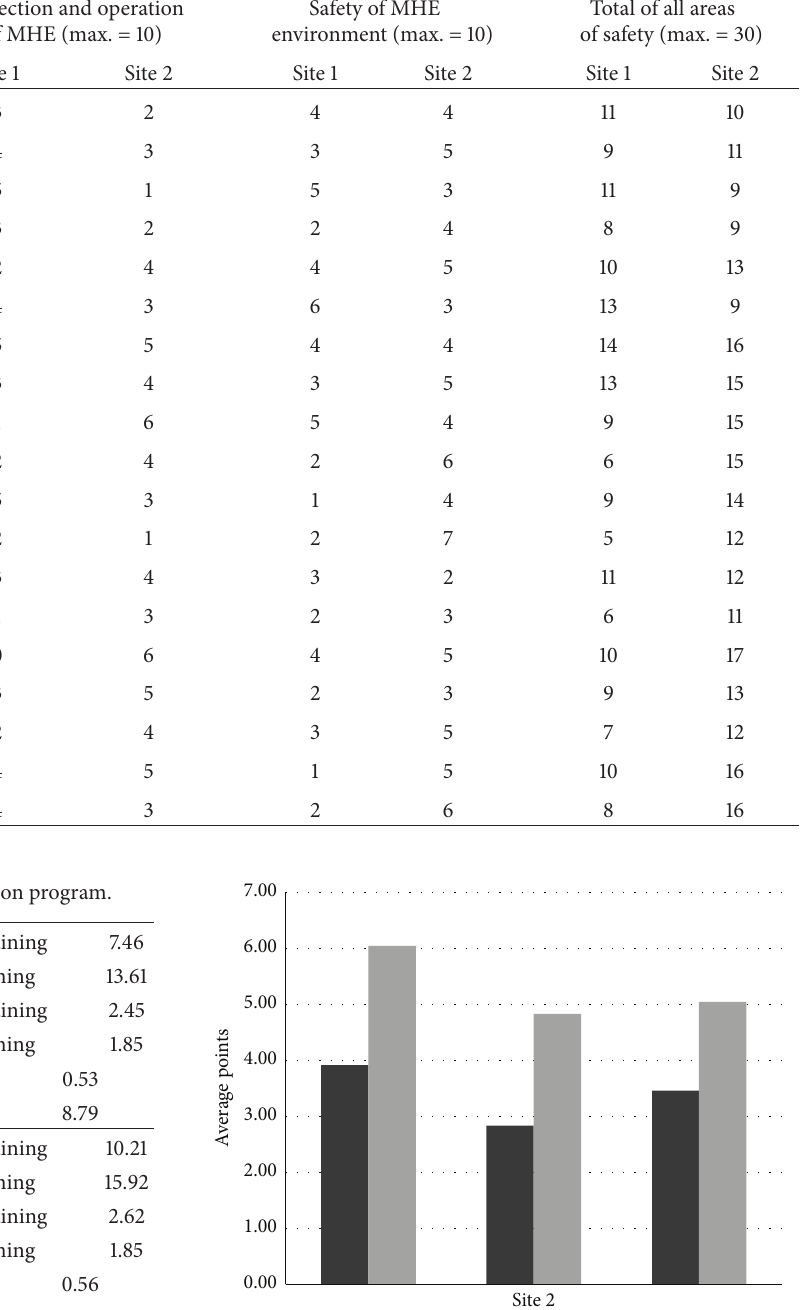
Table 5: Points obtained by workers before training.